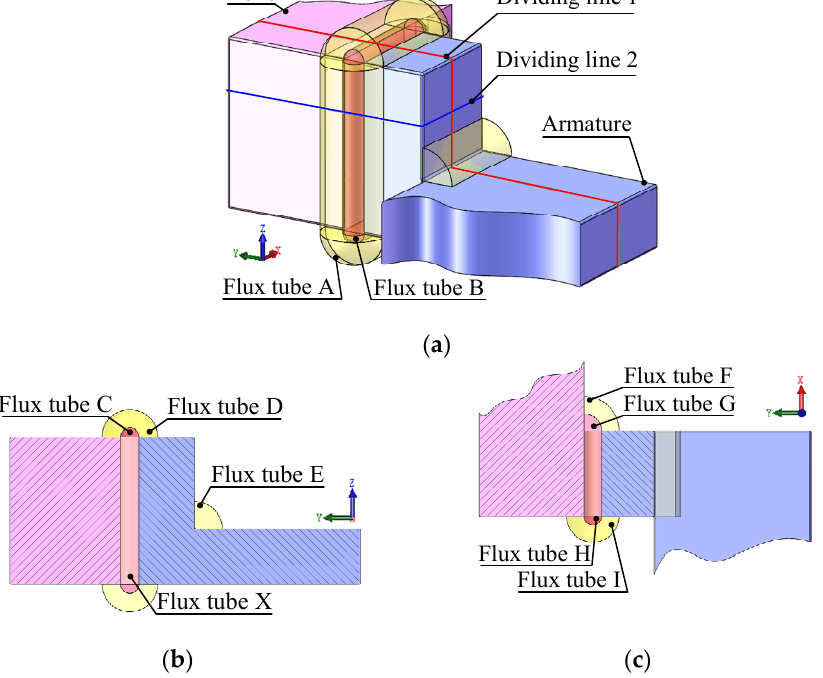
Figure 7. A schematic of segmented magnetic flux tubes. ( a ) Flux tube A&B; ( b ) Flux tube C, D, E&X; ( c ) Flux tube F, G, H&I.